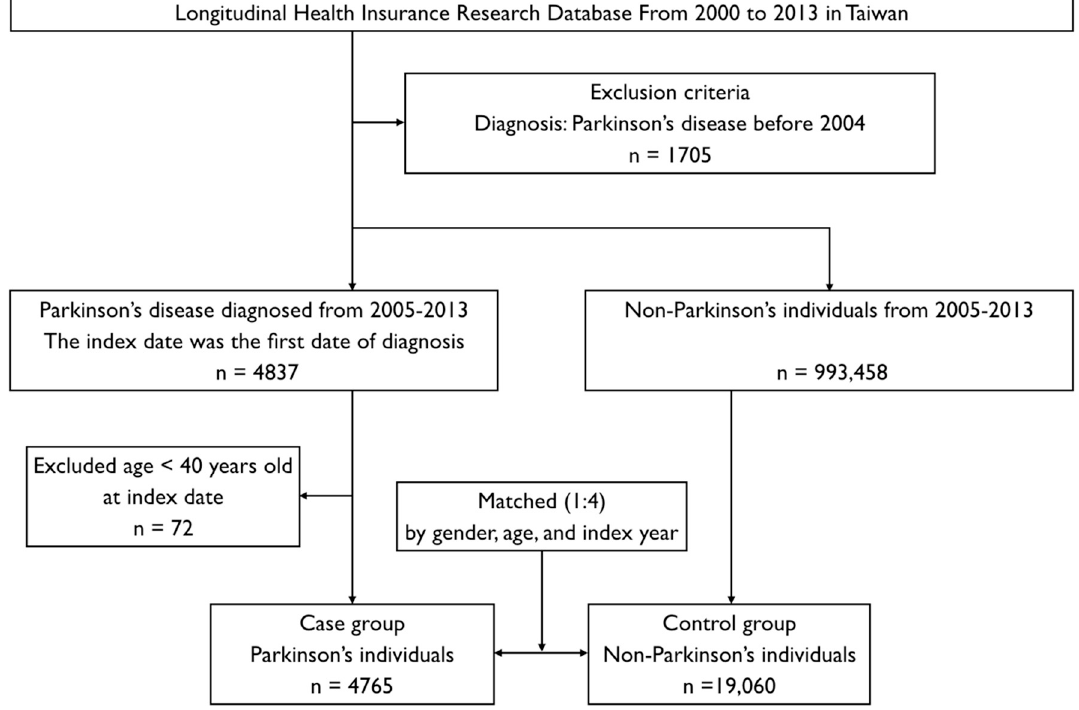
Figure 1. Flowchart of case-control selection of patients from the National Health Research Institute.